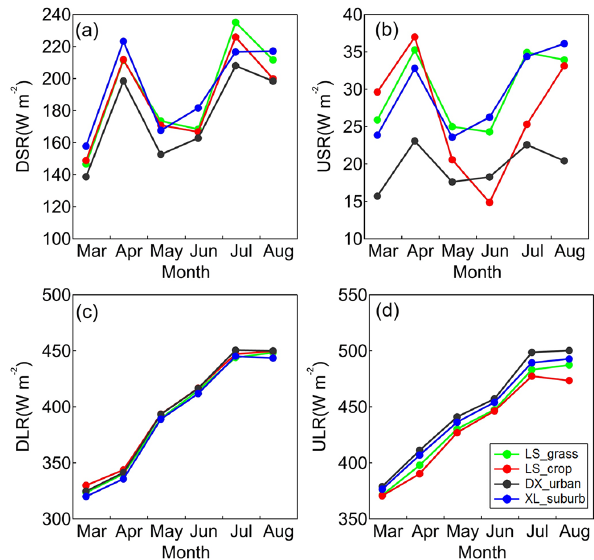
Figure 5. Monthly variation in (a) downward shortwave radiation (DSR), (b) upward shortwave radiation (USR), (c) downward long- wave radiation (DLR), and (d) upward longwave radiation (ULR) at the four sites in